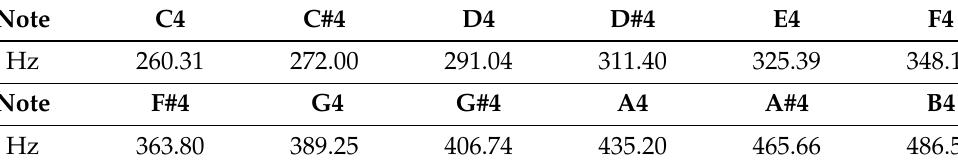
Table 6. Frequencies of notes in the middle octave at 15.0 ◦ C.